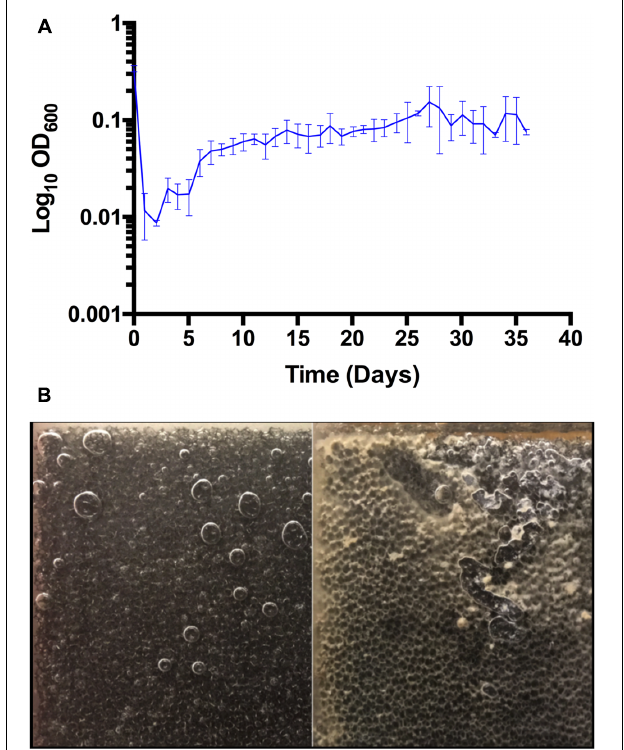
FIGURE 1 | (A) Optical density (600 nm) of planktonic cells in triplicate bioelectrochemical reactors (SD, n = 3). (B) Biofilm growth on RVC cathode. Photographs of uninoculated (left) and inoculated (right) 45 ppi RVC cathodes at 36